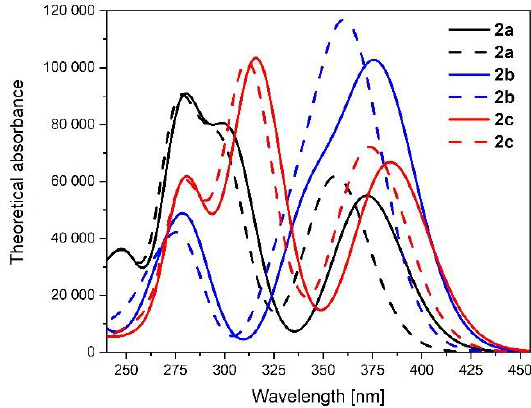
Figure 5. Theoretically calculated CAM-B3LYP (solid line) and wB97XD (dotted line) absorption spectra for 2a–2c.